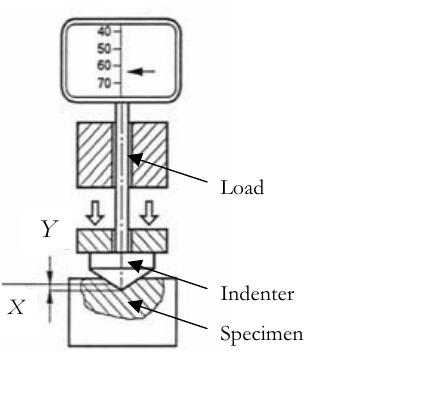
Figure 2 – Theoretical pattern (-), experimental data (o) and regression patterns of the constant and parabolic parts (--); in this case the two parts do not